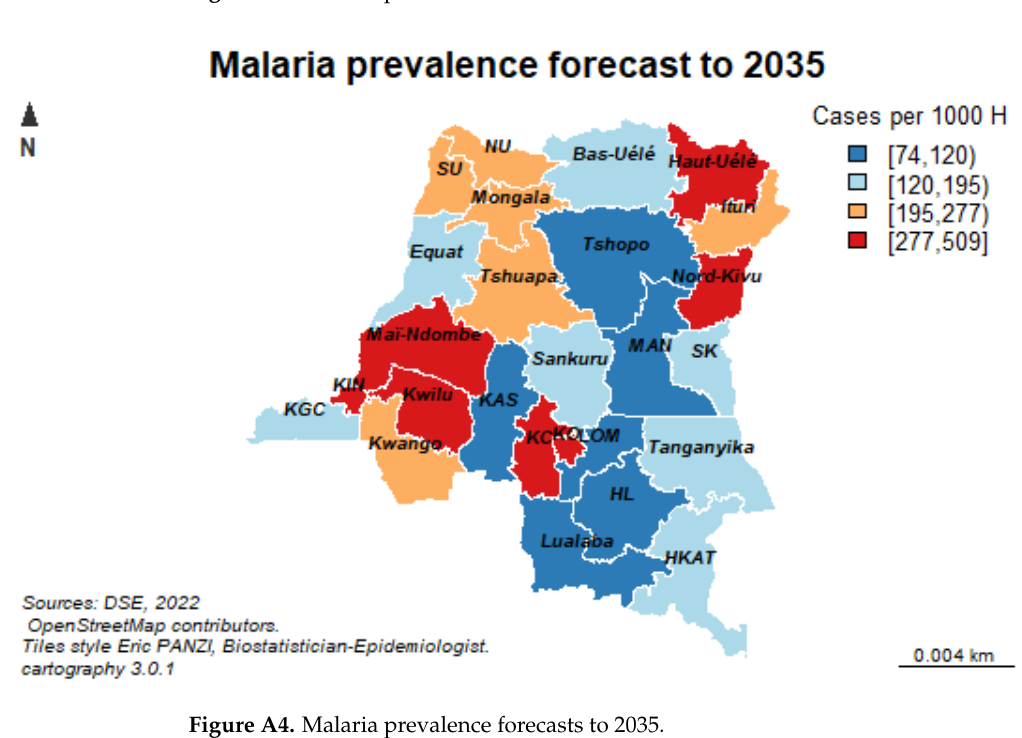
Figure A3. Malaria prevalence forecasts to 2030.